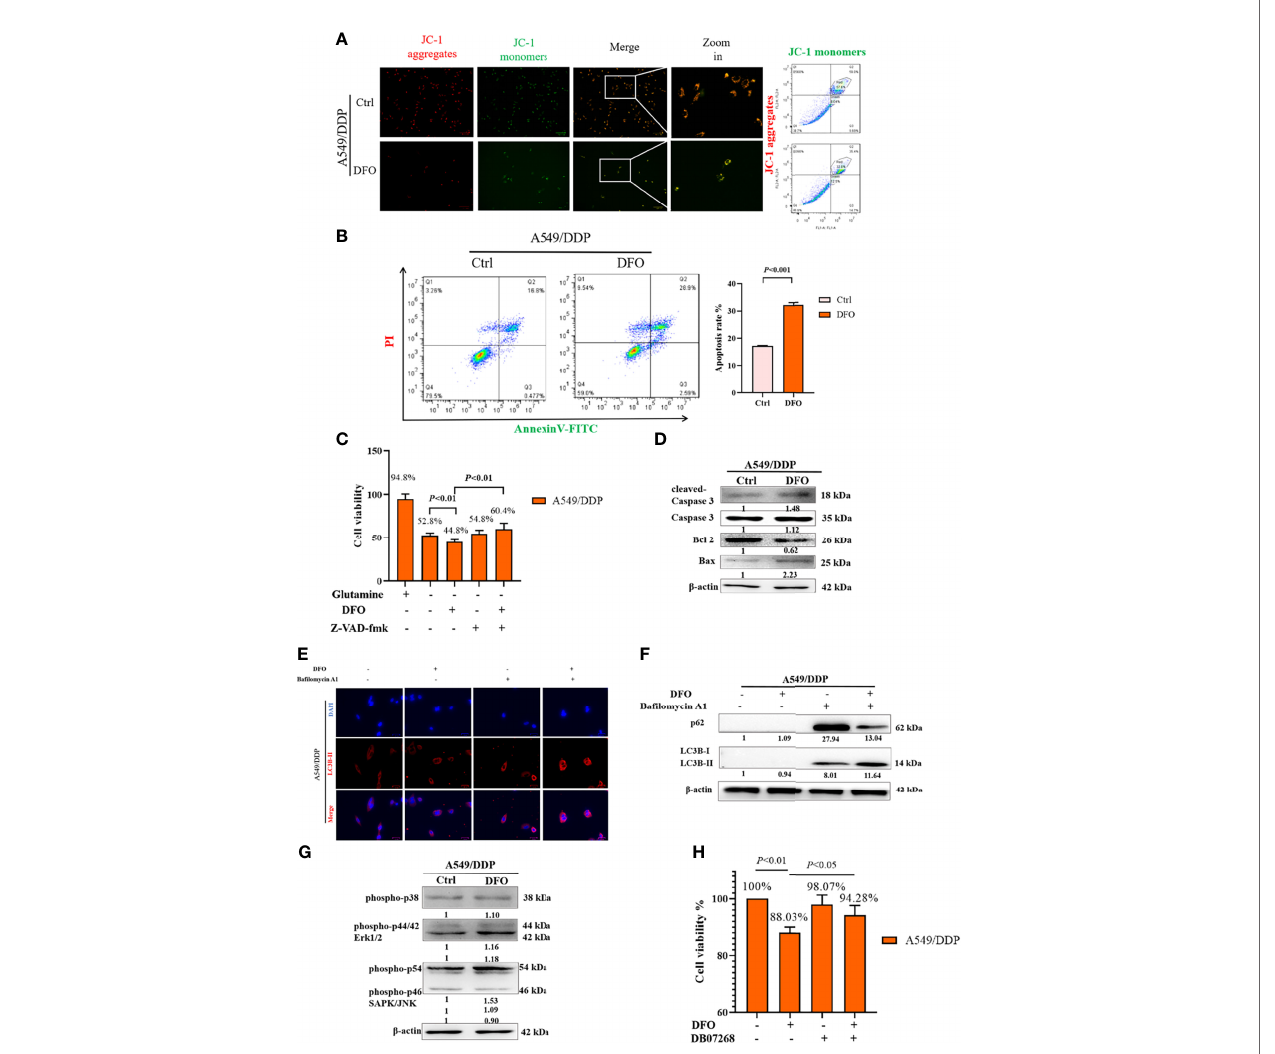
FIGURE 6 | DFO induces autophagic cell death and apoptosis by activating ROS-mediated JNK signaling in A549/DDP cells during glutamine deprivation. Effects of DFO (100 m M; 48 h) on: (A) MMP as measured by JC-1 probe in A549/DDP cells during 48 h glutamine deprivation; (B) apoptosis in A549/DDP cells during glutamine deprivation for 48 h; (C) viability of A549/DDP cells after Z-VAD-fmk (5 µM; 48 h) treatment during glutamine deprivation for 48 h; (D) apoptosis-related protein expression in A549/DDP cells during 48 h glutamine deprivation; (E) immunostaining after BA1 treatment (10 nM; 48 h) of LC3B A549/DDP cells cultured without glutamine for 48 h (red = LC3B, blue = DAPI); (F) autophagic fl ux after BA1 treatment (10 nM; 48 h) in A549/DDP cells cultured in glutamine-restricted conditions for 48 h, with b -actin serving as a loading control. (G) Blots of MAPK signaling in DFO-treated (100 m M; 48 h) A549/DDP cells during 48 h glutamine deprivation; b -actin served as a loading control. (H) Viability of A549/DDP cells after DFO (100 m M; 48 h) and JNK-IN-8 (10 nm; 48 h) treatment during glutamine deprivation for 48 h. All experiments were repeated at least thrice, and the results are expressed as mean ±